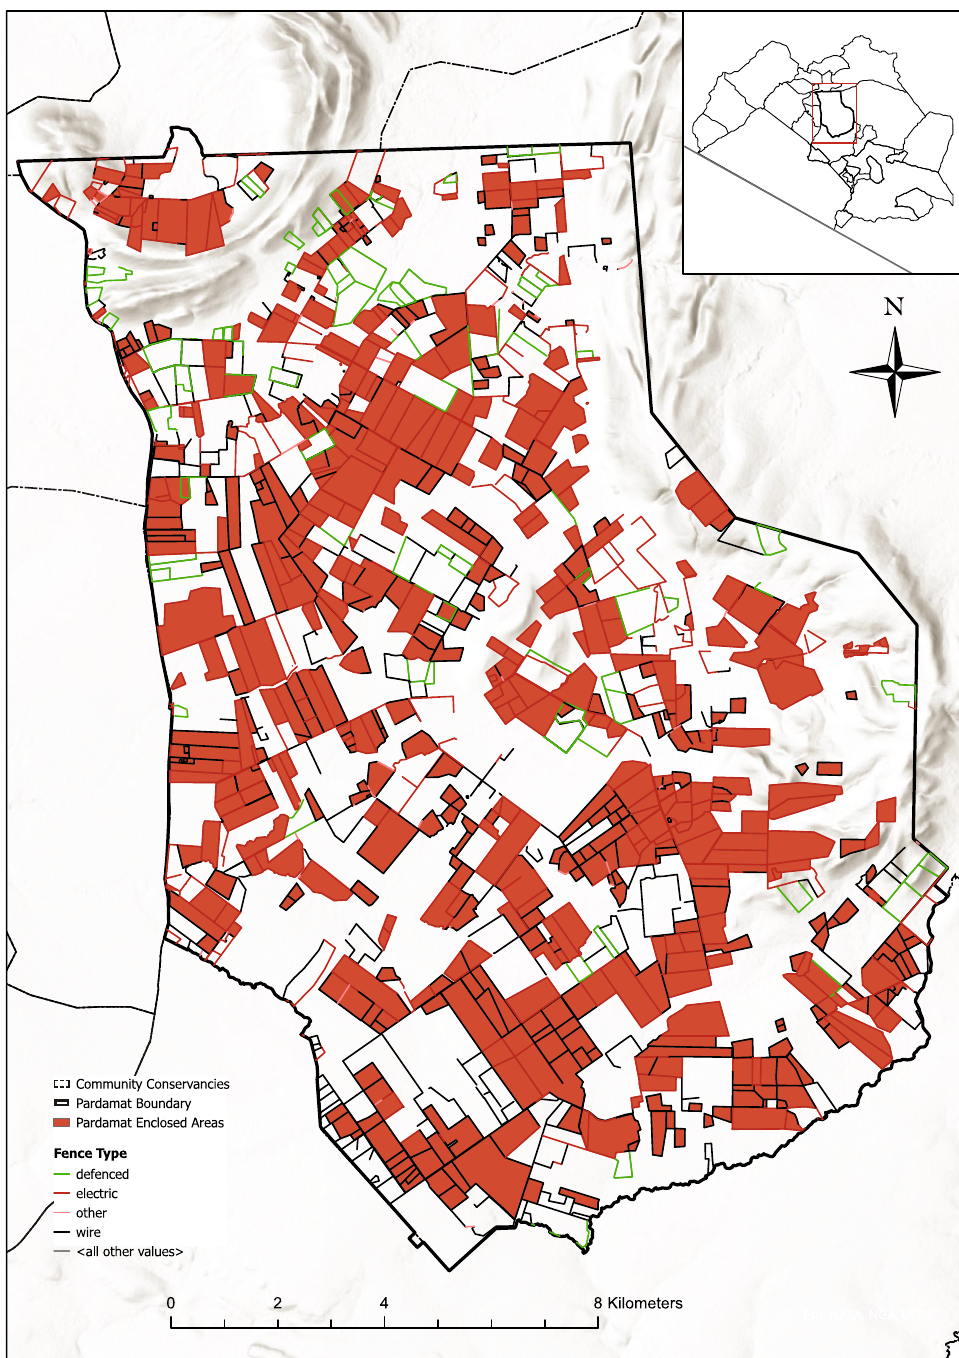
Figure 7. Pardamat fences collected between late September 2019 and September 2021 using GPS ground- truthing. Enclosed areas were calculated by converting recorded fencelines to polygons within Esri ArcGIS Pro vs. 2.9 software 21 allowing for smaller than 2 m gaps. Green lines represent fences that were removed by landowners during the reported